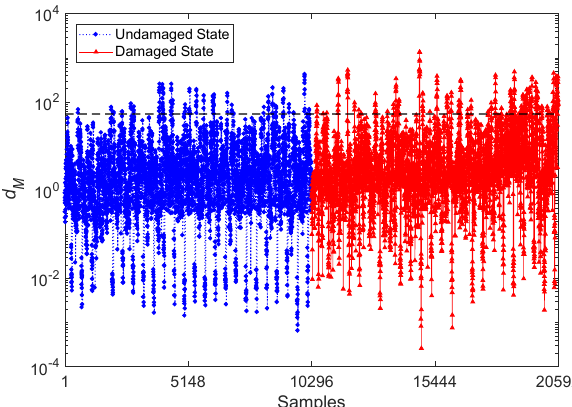
Figure 7. Evolution of the distance value d M obtained by the conventional Mahalanobis-squared distance (MSD) technique and by the CBFE algorithm, using the ARMA(33,33) model.